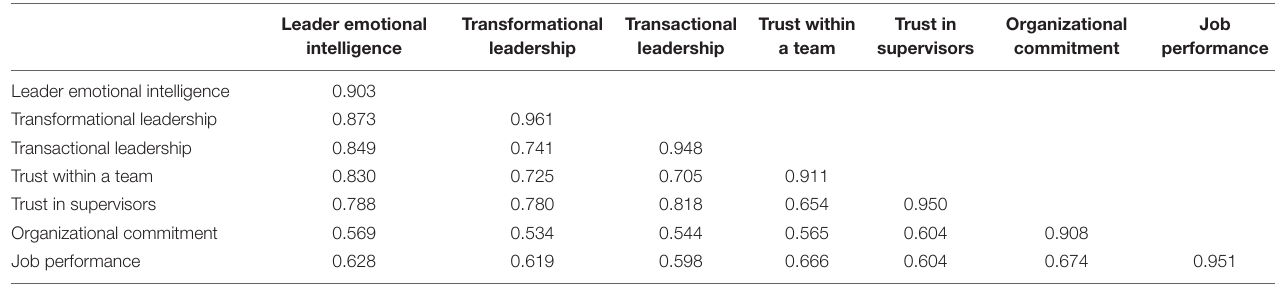
TABLE 3 | Correlation matrix of latent